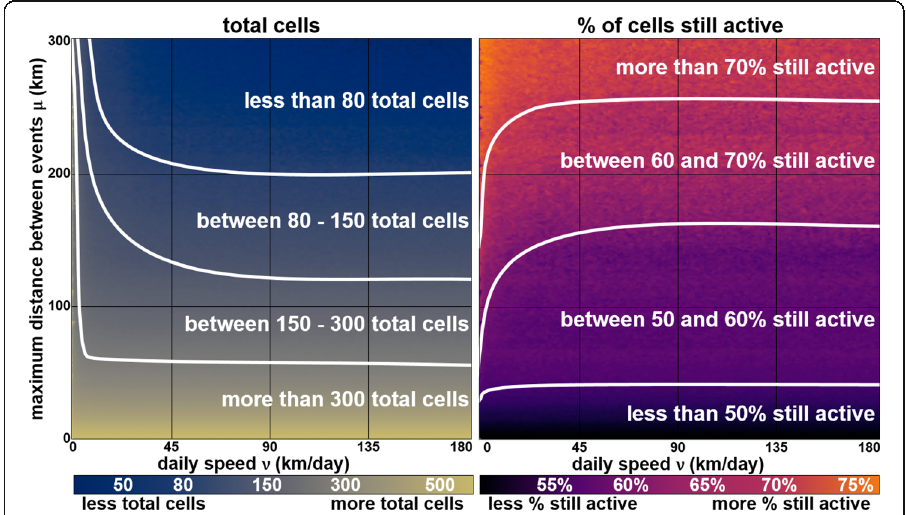
Fig. 9 Total number of cells T 2019 ( ν , μ ) (left) and the ratio between the active number of cells and the total number of cells A 2019 ( ν , μ )/ T 2019 ( ν , μ ) (right) for a range of daily speeds and maximum distance between consecutive